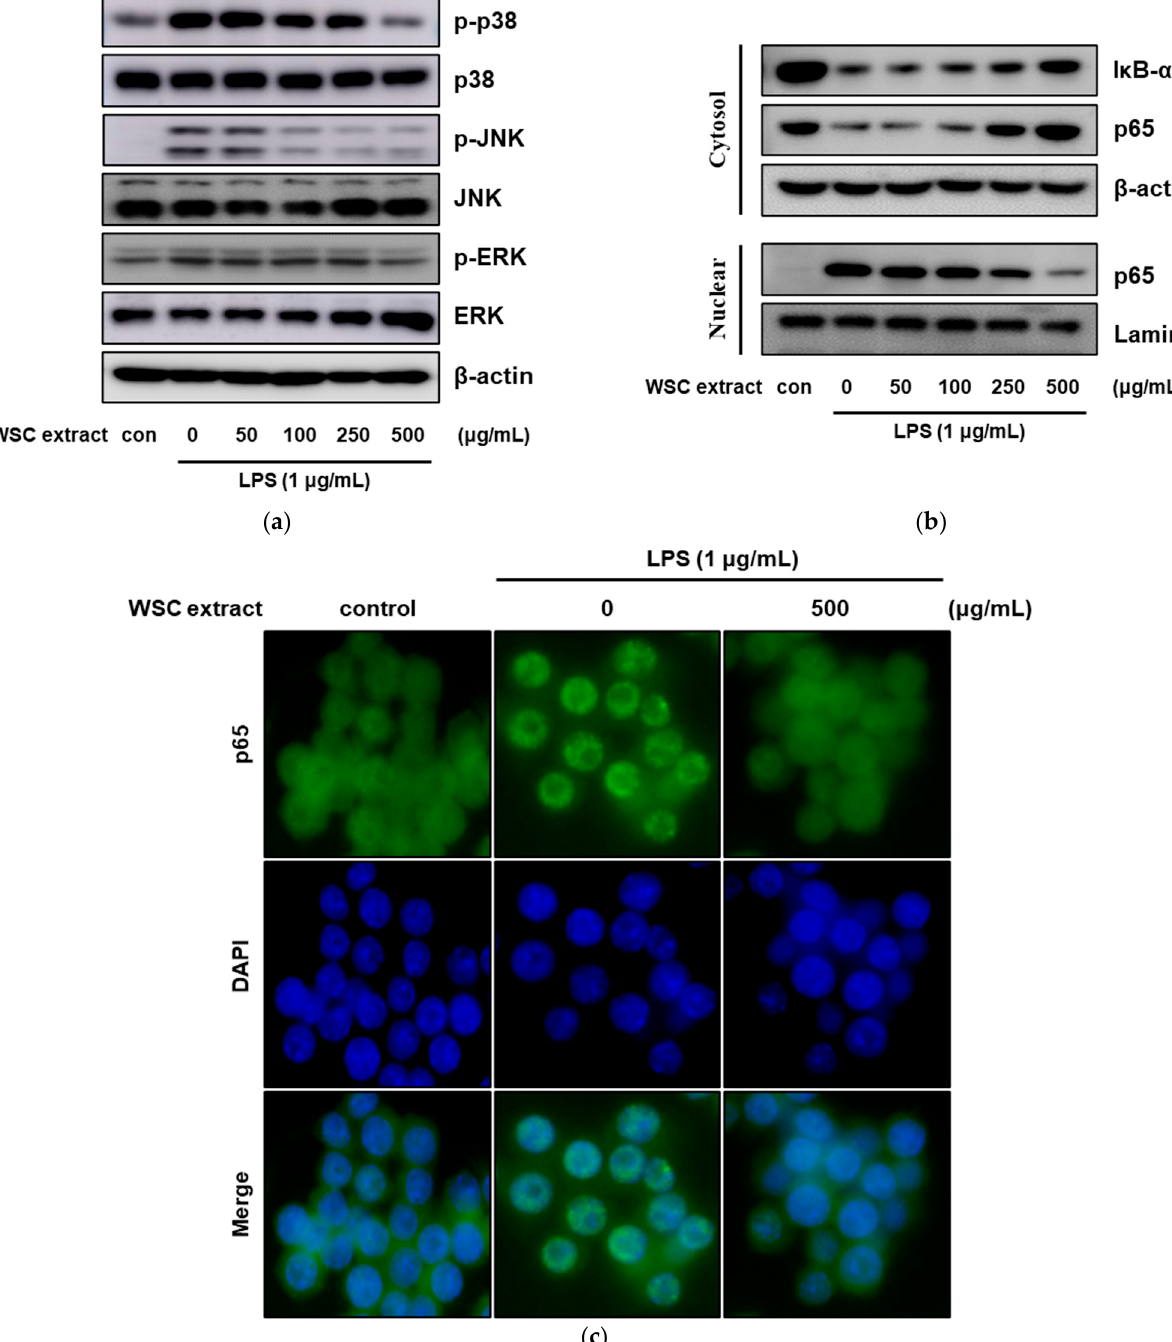
Figure 5. Effect of the WSC extract on MAPK signaling and nuclear translocation of NF- κ B in LPS-treated RAW264.7 cells. The cells were pretreated with the indicated concentrations of the WSC extract for 3 h and then treated with 1 µ g/mL of